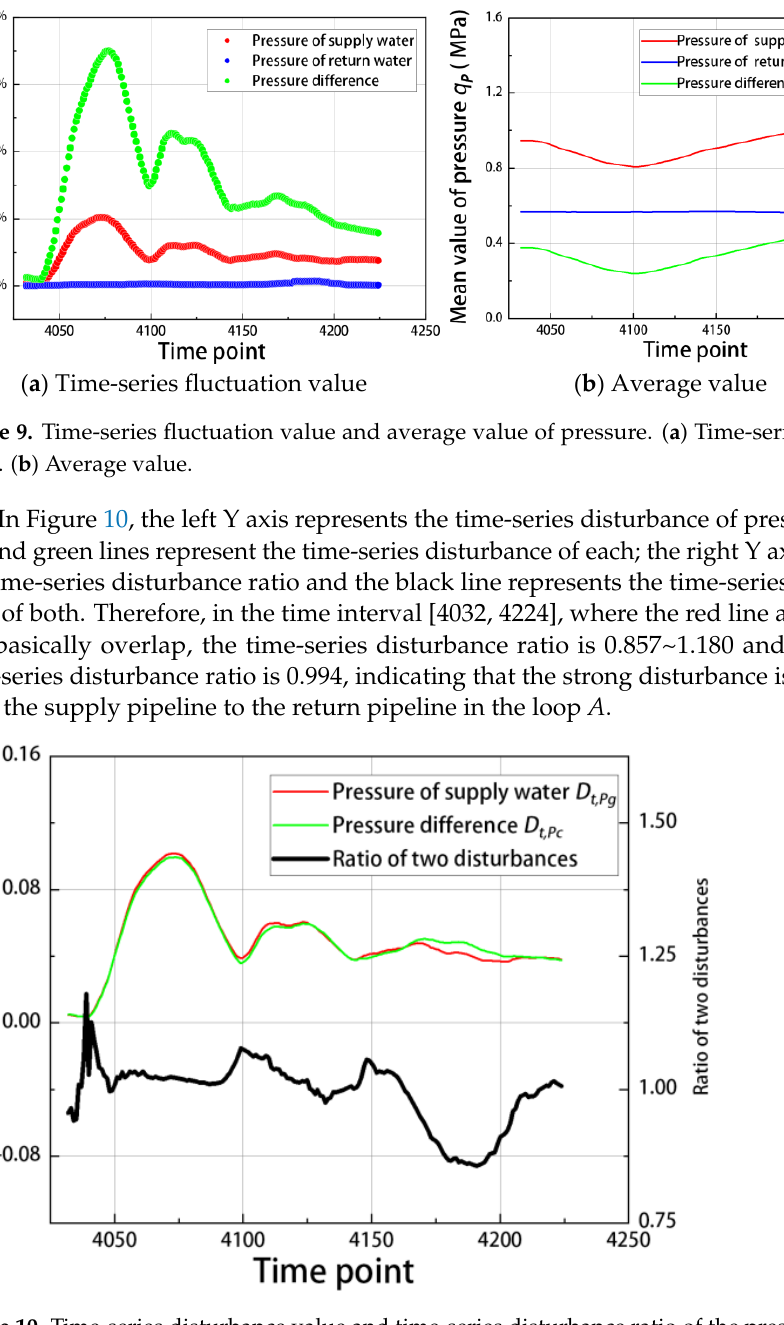
Figure 10. Time-series disturbance value and time-series disturbance ratio of the pressure